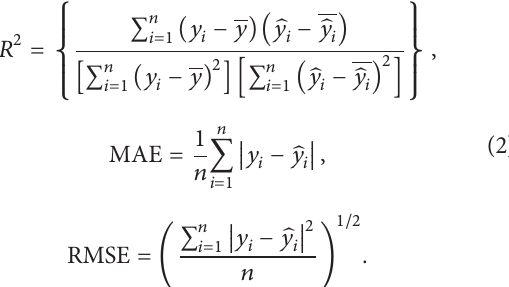
(RMSE) for the evaluation. Equations for 𝑅 2 , MAE,